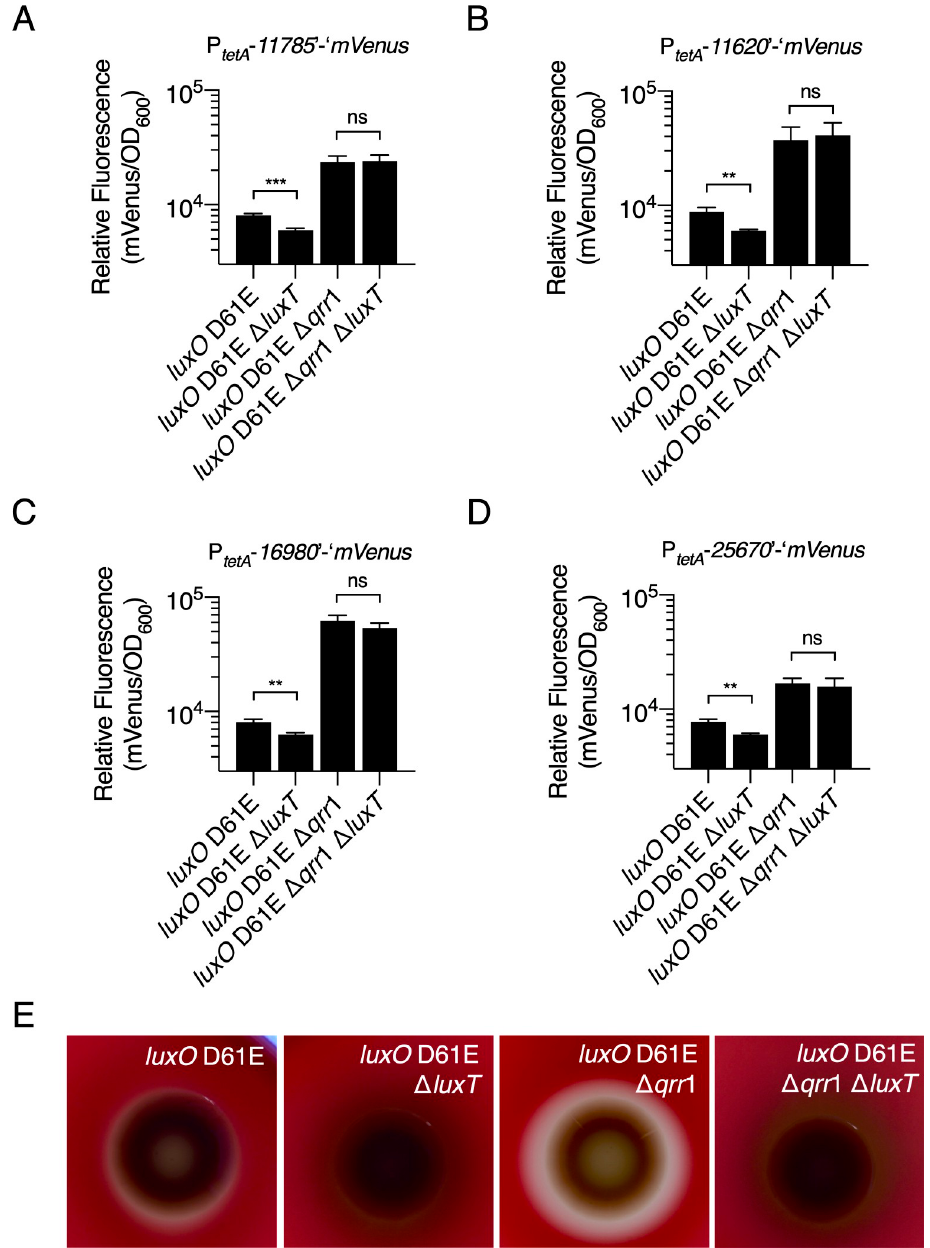
Fig 5. LuxT post-transcriptionally activates target genes via repression of qrr 1. (A-D) Relative fluorescence values (mVenus/OD 600 ) of the indicated V . harveyi strains harboring plasmids carrying translational mVenus reporters to the indicated genes. In all cases, 100 ng mL -1 aTc was added to induce constitutive transcription of the reporters from the tetA promoter. Values represent relative fluorescence at OD 600 = 0.3 for each sample. Error bars represent standard deviations of the means of n = 3 biological replicates. Unpaired two-tailed t tests with Welch’s correction were performed comparing two samples, as indicated. p -values: ns � 0.05, �� < 0.01, ��� < 0.001. (E) Halo formation by the indicated V . harveyi strains on TSA plates containing 5% sheep’s blood. Plates were incubated at 30˚C for 72 h. A zone of clearing surrounding the colony indicates aerolysin-driven